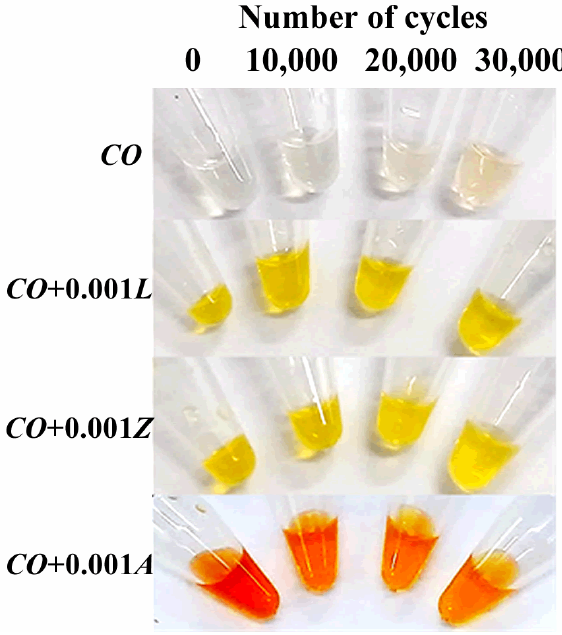
Figure 10. CO with different xanthophylls during lubricated friction tests.